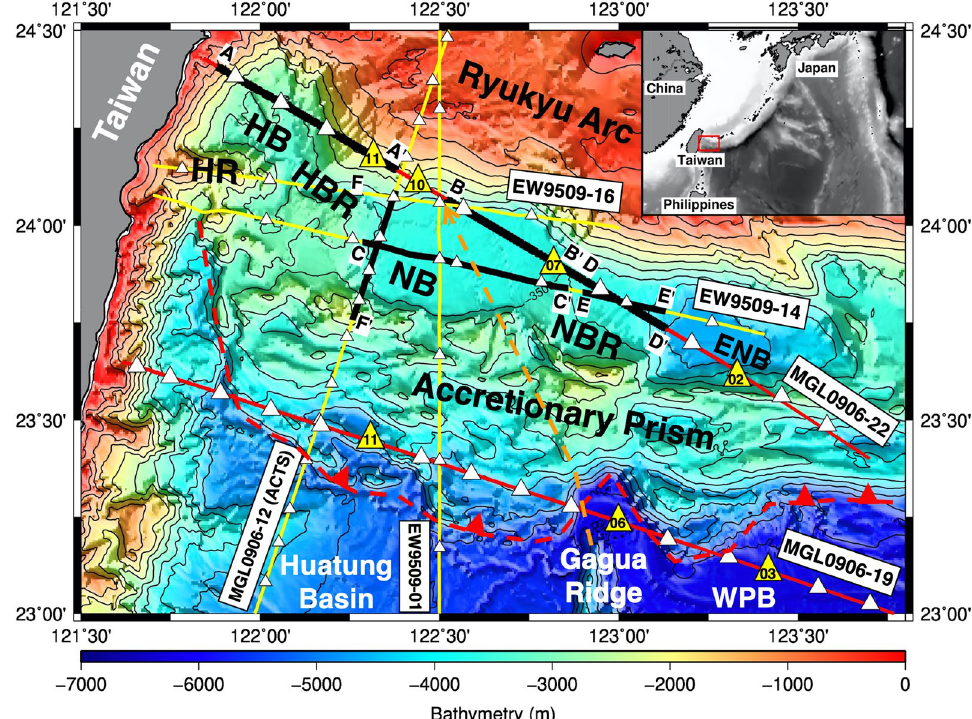
Fig. 2 The bathymetry map with seismic lines at the southernmost Ryukyu Trench. During 1995 TAICRUST and 2009 TAIGER projects, LMCS data were collected, processed, and integrated along EW9509‑01, EW9509‑14, EW9509‑16, MGL0906‑12, MGL0906‑19, and MGL0906‑22. OBSs are indicated by the white triangles. The capital letters of A, B, C, D, E, F and A’, B’, C’, D’, E’, F’ indicate respectively the starting point and endpoint of the MCS data shown in Figs. 3, 4, 5, 6, Additional file 1: Figs. S5 and S6. The yellow triangles show where the images of OBS data in Figs. 7, 8, Additional file 1: Figs. S7 and S8 are located. The red dashed line indicates the Ryukyu Trench with the red triangles which show the direction of subduction. The Gagua Ridge might be obliquely subducted toward the NW direction indicated by the orange dashed‑line arrow. The contour lines are bathymetry with the contour interval of 500 m. WPB: West Philippine Basin, HR: Hsincheng Ridge, HB: Hoping Basin, HBR: Hoping Basement Rise, NB: Nanao Basin, NBR: Nanao Basement Rise, ENB: East Nanao